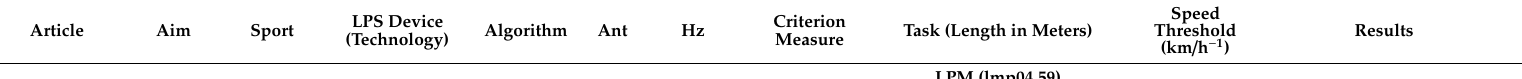
Table A2. Studies that assess validity or reliability of